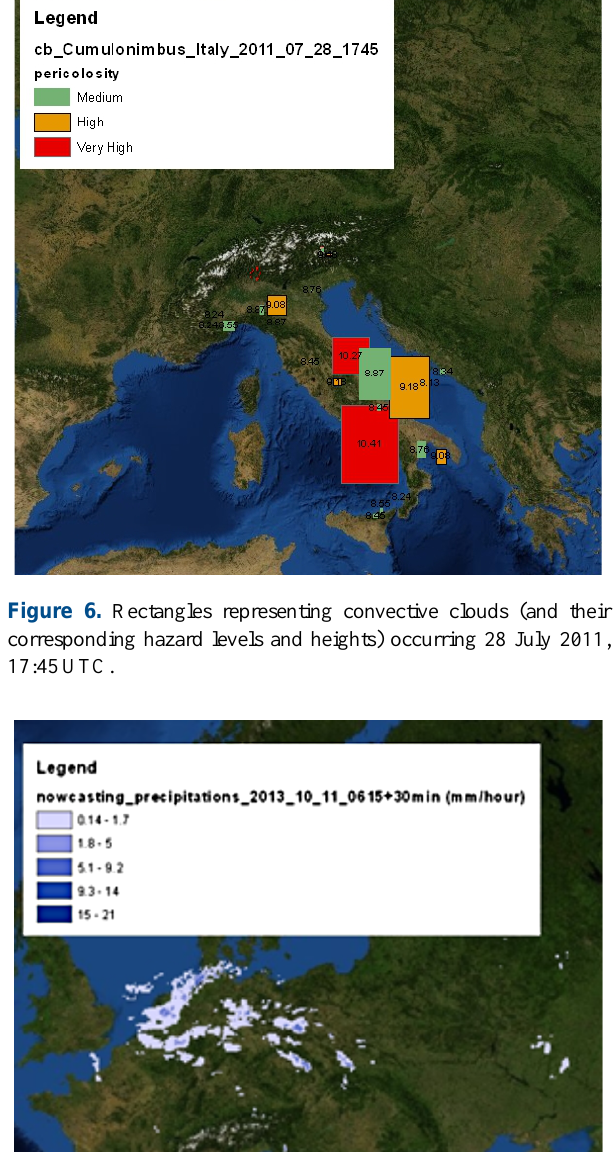
vective clouds observed during 28 July 2011 at 17:45 UTC are reported as rectangles.